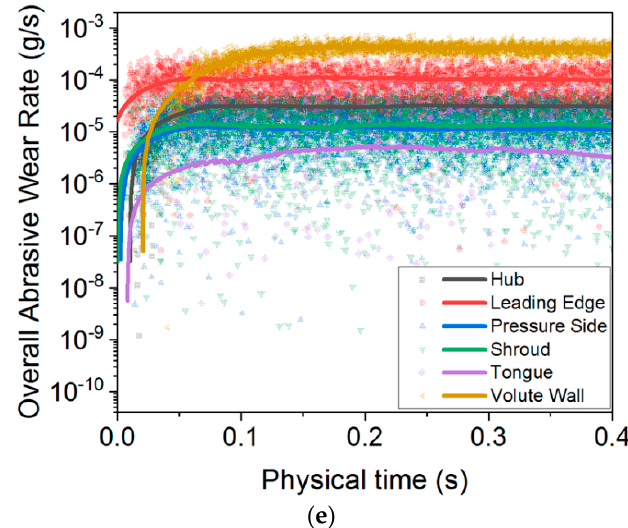
Figure 7. Overall abrasive wear rate of flow parts as a function of time: ( a ) tetrahedron, ( b ) hexahedron, ( c ) octahedron, ( d ) dodecahedron, and ( e ) sphere.